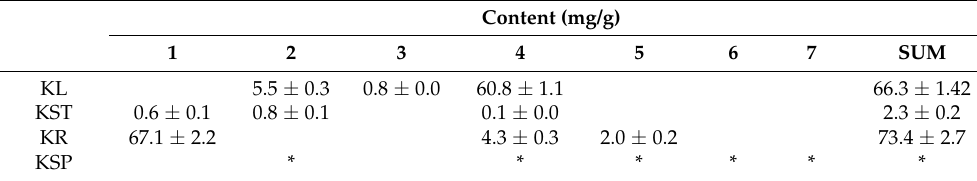
Table 2. The content of seven major compounds by extraction part of kudzu.